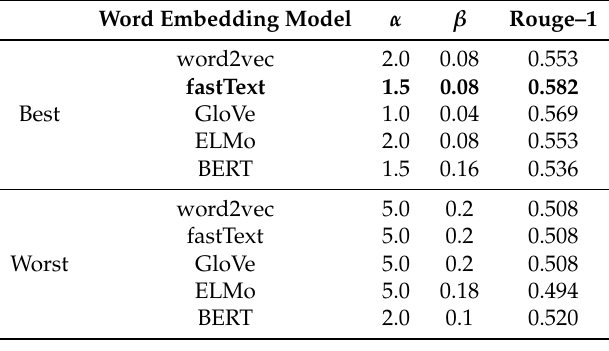
Table 4. The best Dirichlet priors.